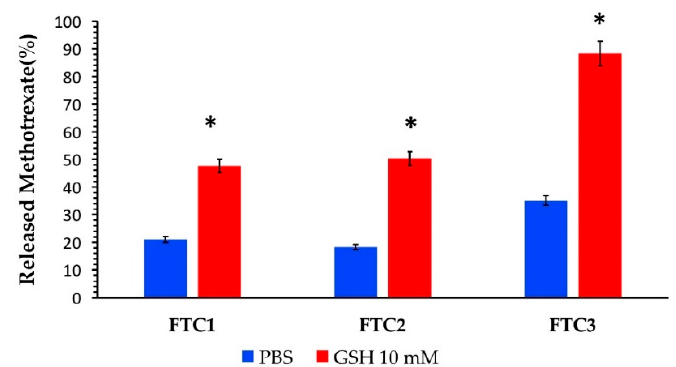
Figure 4. Percentage of MTX released from NPs based on FTC polymers with different amounts of disulfide content (FTC1 65.87%; FTC2 92.29%; FTC3 70.71%) in phosphate buffer in the presence and absence of GSH 10 mM at 25 °C (mean ± standard deviation, n = 3). The amount of MTX release in phosphate buffer in the presence of GSH 10 mM was statically different (* p < 0.05) from that recorded in the absence of GSH.